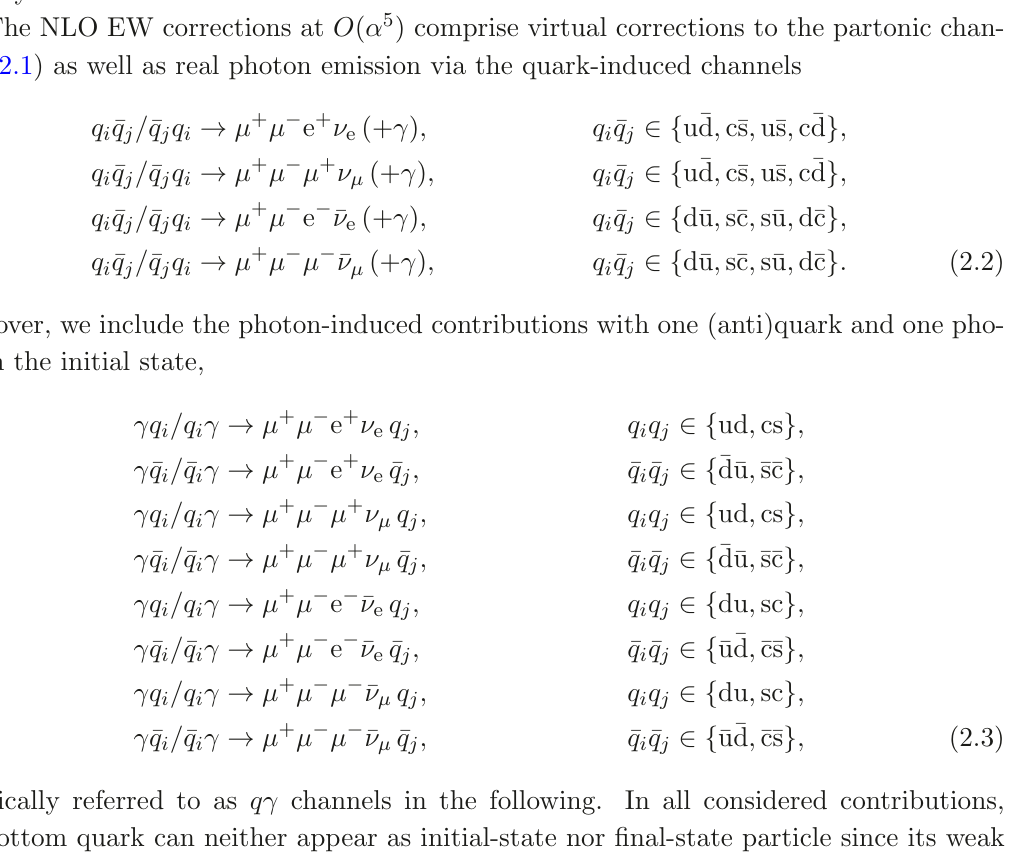
Figure 1 . Sample tree-level diagrams contributing at O ( α 4 ) to q i ¯ q j 10% and 20%. Channels involving quarks of the first and anti-quarks of the second gen- eration or vice versa, stay at the percent level. Sample tree-level diagrams contributing to the process q i ¯ q j µ + µ − e + ν e are shown in figure 1. Besides diagrams with a resonant → W boson and a resonant Z boson or a photon these involve also diagrams with only one possibly resonant vector